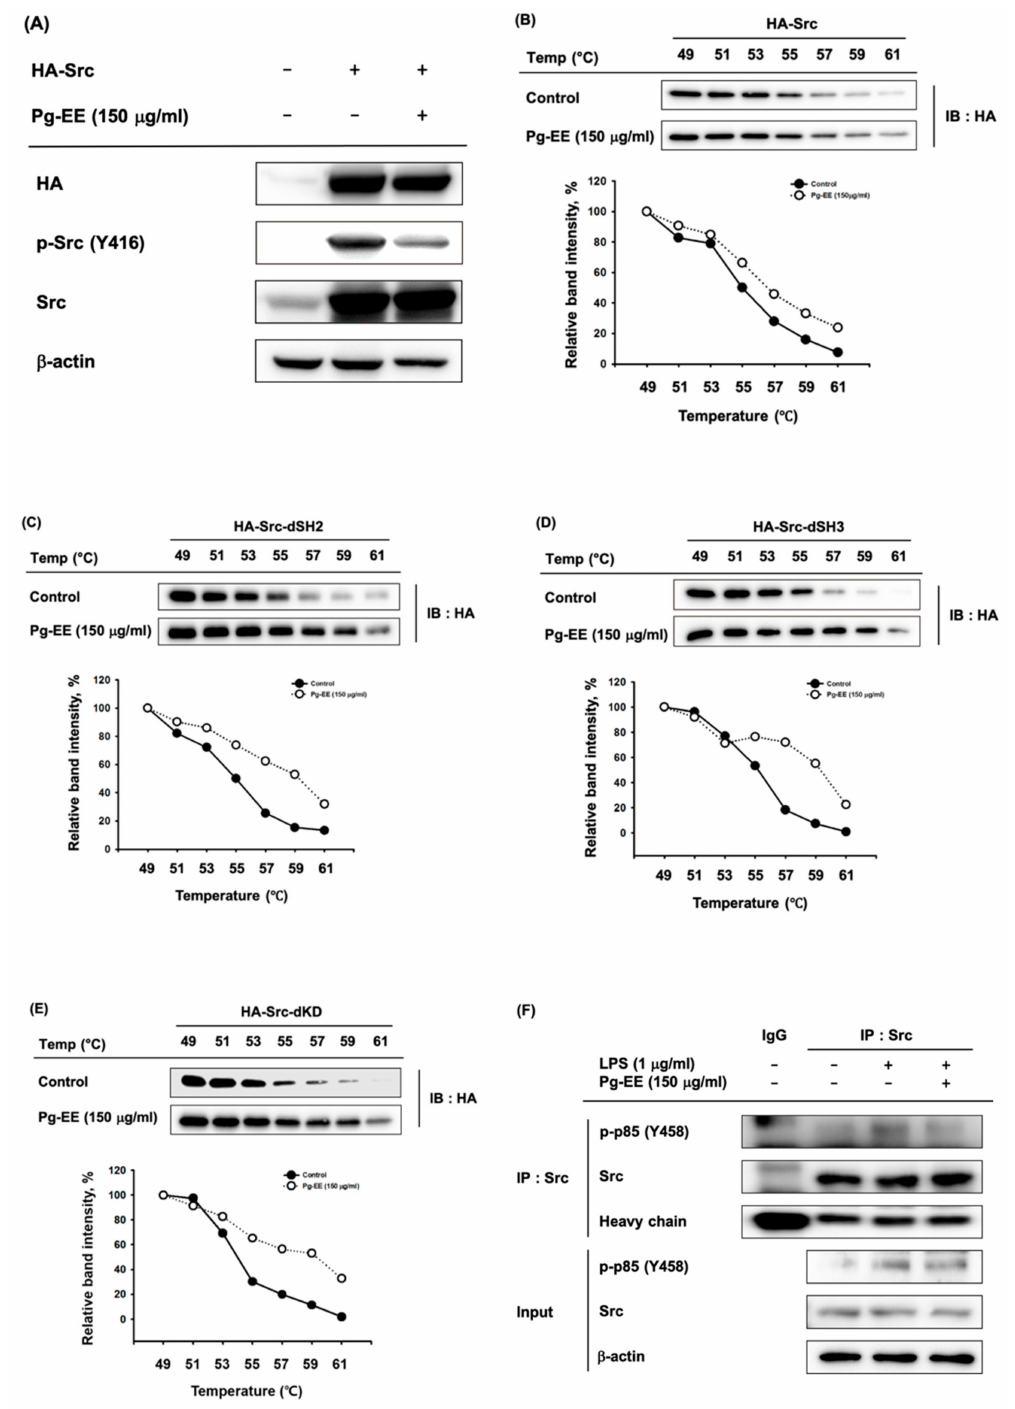
Figure 4. ( A ) HEK293T cells were transfected with HA-Src constructs for 24 h and treated with Pg-EE as indicated. Western blot analysis was performed for HA, total Src, and phosphorylated Src (Tyr416). ( B – E ) After overexpressing the Src and Src domain deletion constructs in HEK293T cells, a cellular thermal shift assay (CETSA) was performed with Pg-EE (150 µ g / mL) or DMSO (as a control). Stabilization of Pg-EE on Src was examined by western blot analysis. The calculation of band intensity of Src in Pg-EE- and DMSO-treated groups was performed with Image J. ( F ) RAW264.7 cells (5 × 10 6 cells / mL) were incubated with Pg-EE in the presence or absence of LPS (1 µ g / mL) for 0 or 5 min. The binding of phospho-p85 (Tyr458) to Src was detected in whole cell lysates by immunoprecipitation with antibodies to Src and immunoblotting with antibodies to p-p85. − : no treatment and + :